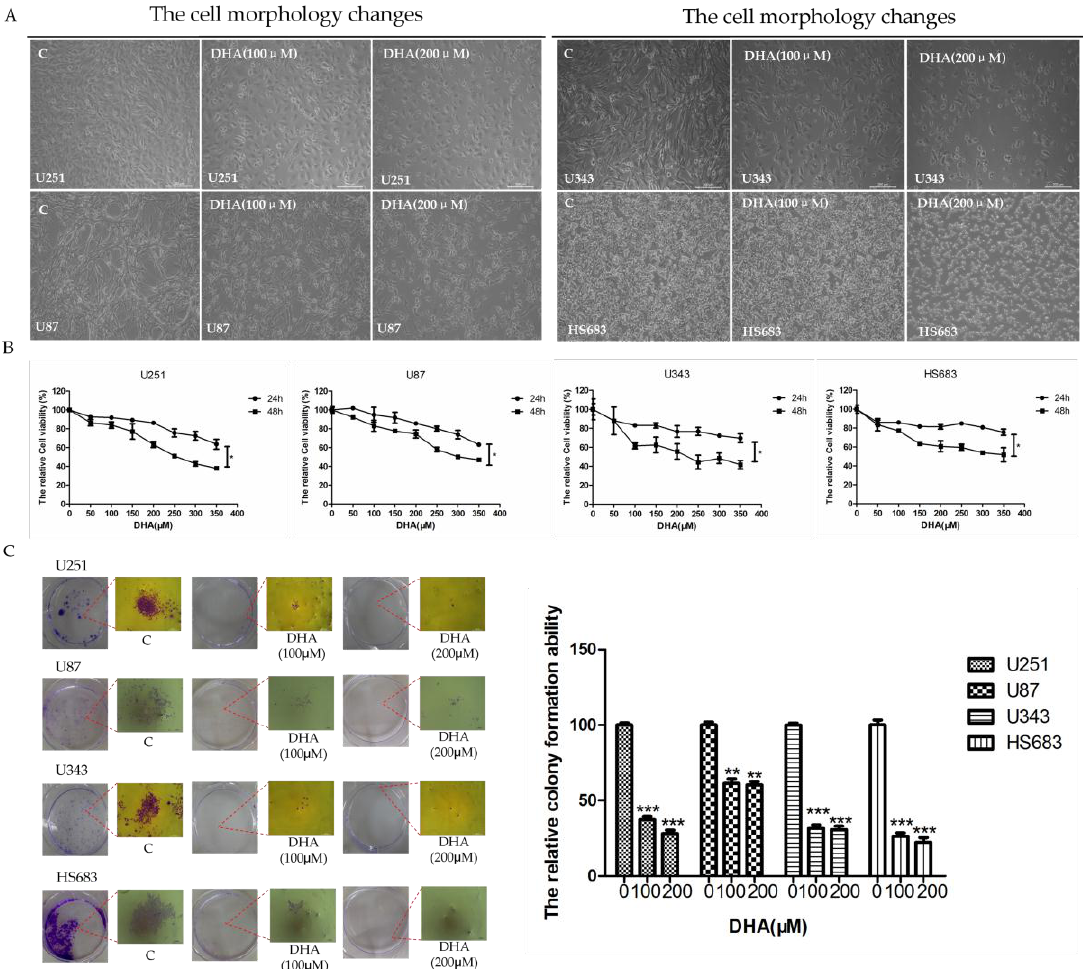
Figure 1. Inhibitive effect of dihydroartemisinin (DHA) on the growth of human malignant glioma cells in vitro. ( A ) Malignant glioma cells (U251, U87, U343, and HS683) were treated with 100 μM and 200 μM DHA for 48 h. Cell morphological changes were determined under phase contrast microscope at 10×; ( B ) Malignant glioma cells (U251, U87, U343, and HS683) were treated with a series of DHA concentrations (0–350 μM) for 24 or 48 h followed by methyl thiazolyl tetrazolium (MTT) assay. Values were mean ± SD ( n = 3). * p < 0.05 as compared with negative control cells; ( C ) Foci formation of U87, U251, U343, and HS683 cells was determined. After indicated treatments, malignant glioma cells were trypsinized and plated in duplicates at low density. After 10 days, formed colonies were stained with crystal violet. Values were mean ± SD ( n = 3), ** p < 0.001, *** p < 0.0001 as compared with negative control cells.